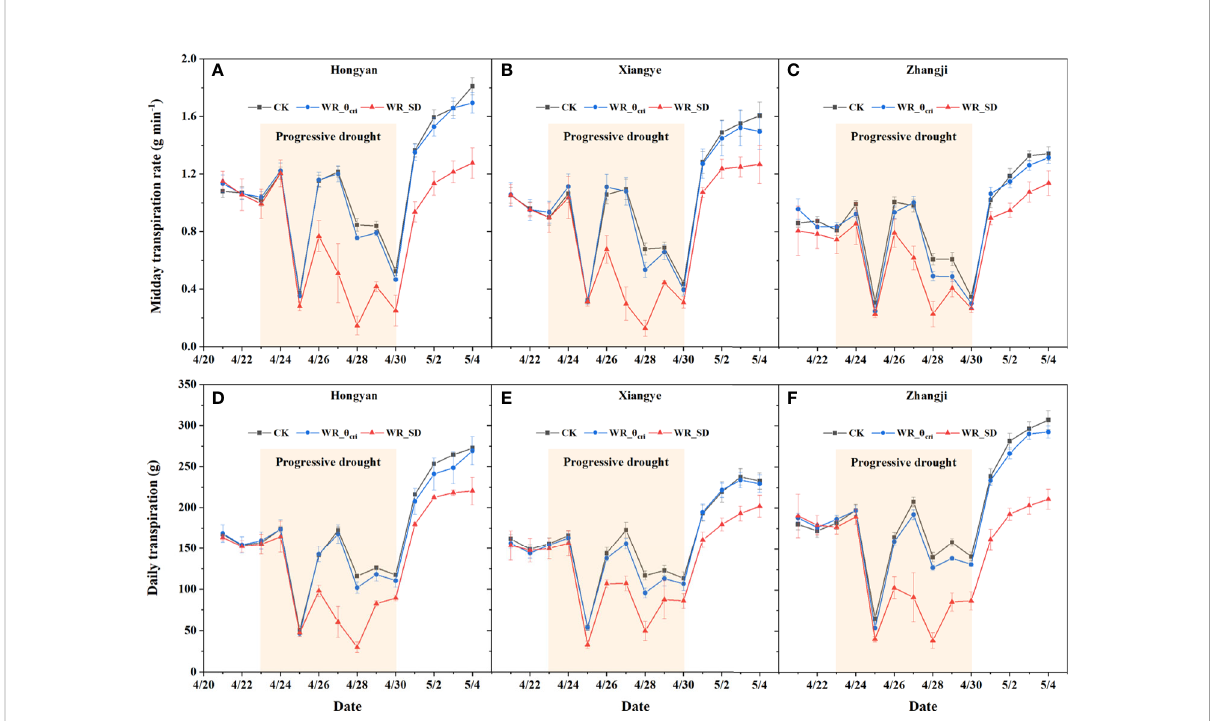
FIGURE 4 Midday transpiration rate (Tr m ) and daily transpiration (E) of different treatments during the spring season for strawberry varieties. Three treatments, i.e., well irrigation across the whole period (CK), water recovery at the critical threshold ( q cri ) when Tr started to reduce signi fi cantly (WR_ q cri ), and water recovery under severe drought (WR_SD), are shown in the graph. Three strawberry varieties, i.e., Hongyan (A, D) , Xiangye (B, E) and Zhangji (C, F) , were used in the